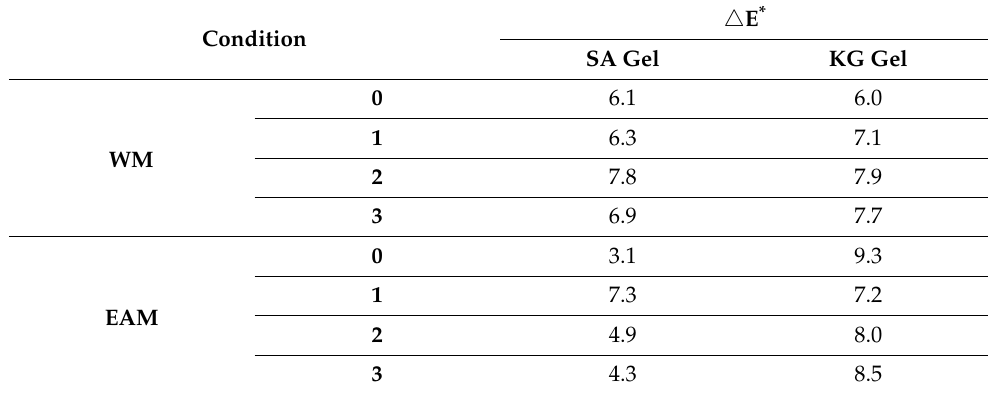
Table 3. The overall chromatic variation ( (cid:52) E * ) calculated between the areas before and after cleaning the soiled-WM and soiled-EAM by repeating cleaning trials using SA and KG gels. Color variation between soiled-WM and WM is 8.3, and that between soiled-EAM and EAM is 4.7.